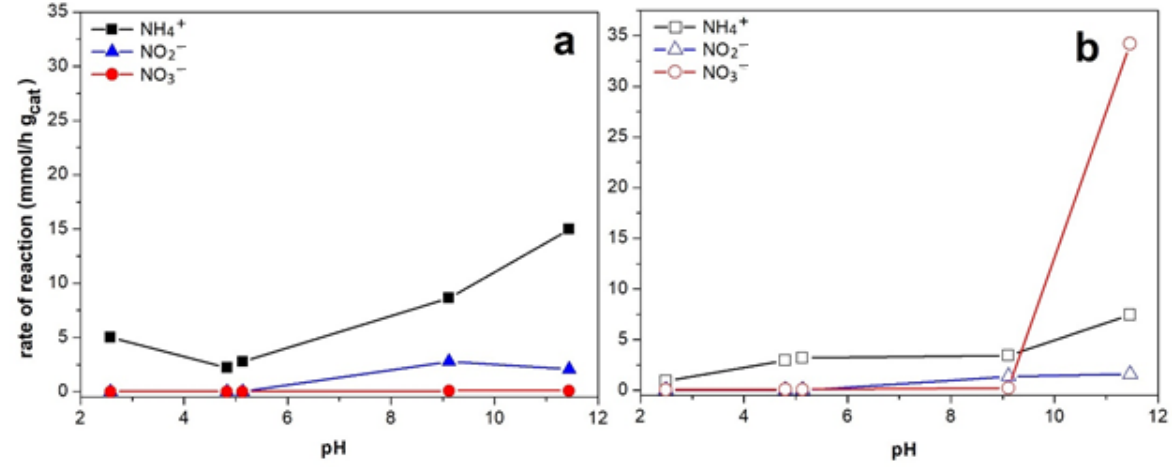
Figure 5. Rate of NH 4 + /NH 3 oxidation and of NO 2 − and NO 3 − production vs. pH, considering the data after 5 h of reaction for ( a ) P25 (solid colored symbols) and ( b ) FSP (hollow symbols). Rate of reaction figures on y-axis of diagrams ( a , b ).